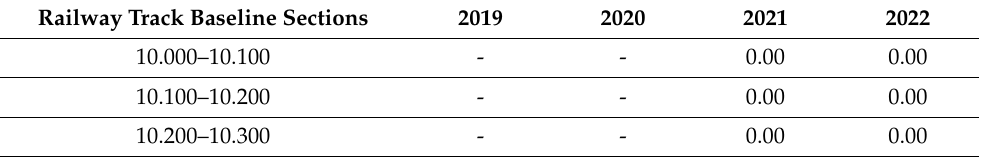
Table A15. Cont. Railway Track Baseline